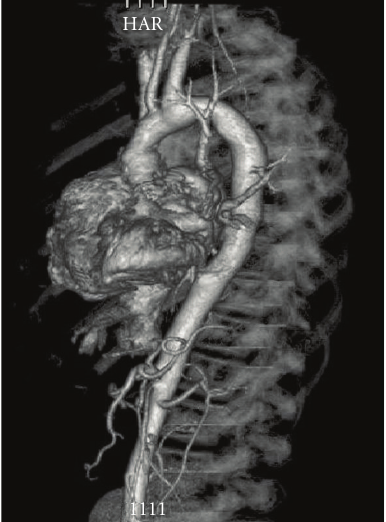
Figure 3: Postoperative CT